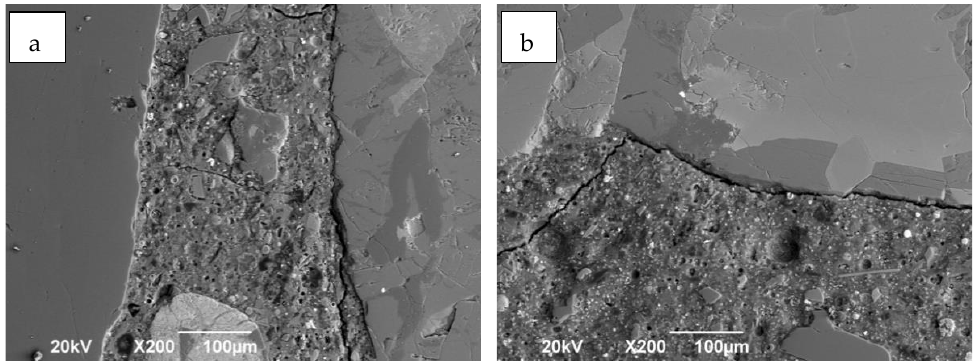
Figure 4. Observation matrix-aggregate interface. ( a ) FA/GBFS y ( b ) FA/OPC.